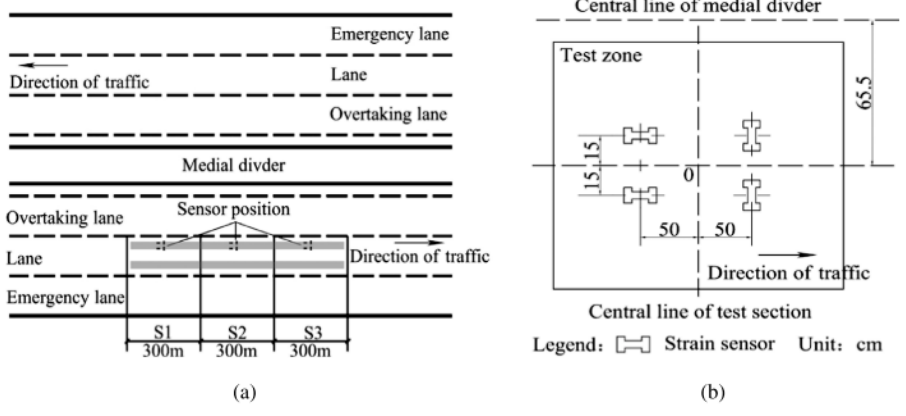
Figure 14. Instrumented section in China. ( a ) Layout of the instrumentation and ( b ) focus on the sensors (figures are reproduced from Ai et al. [43]).